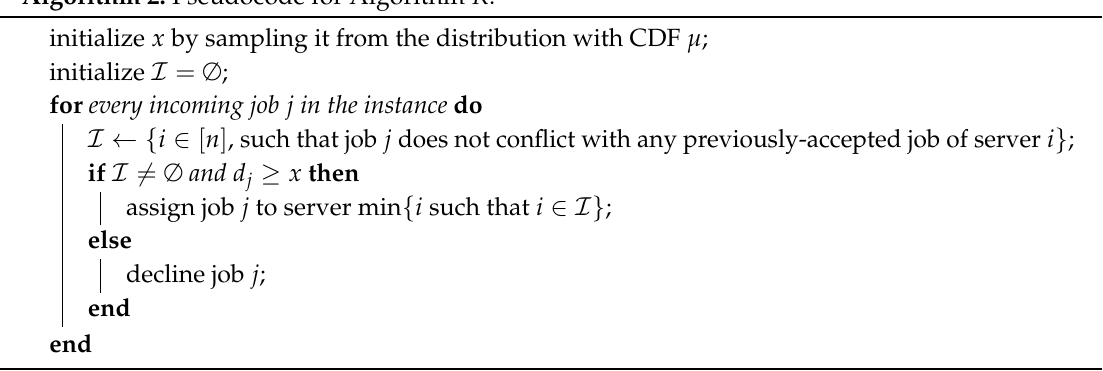
Algorithm 2: Pseudocode for Algorithm R